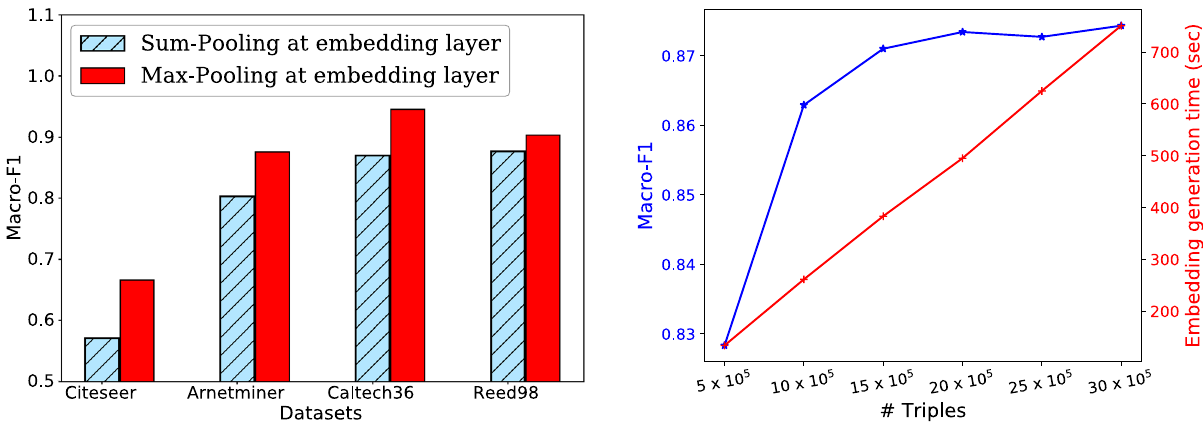
(b) Effect of # triples used for training on performance and time ( Arnetminer dataset)